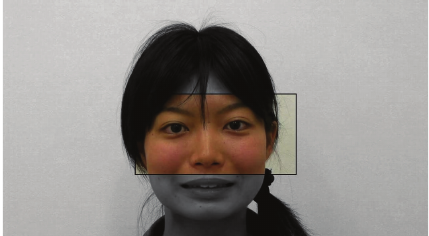
Figure 2: The eye region of the stimuli: the stimuli started only when participants fixate within the black frame for at least 500ms in Experiment